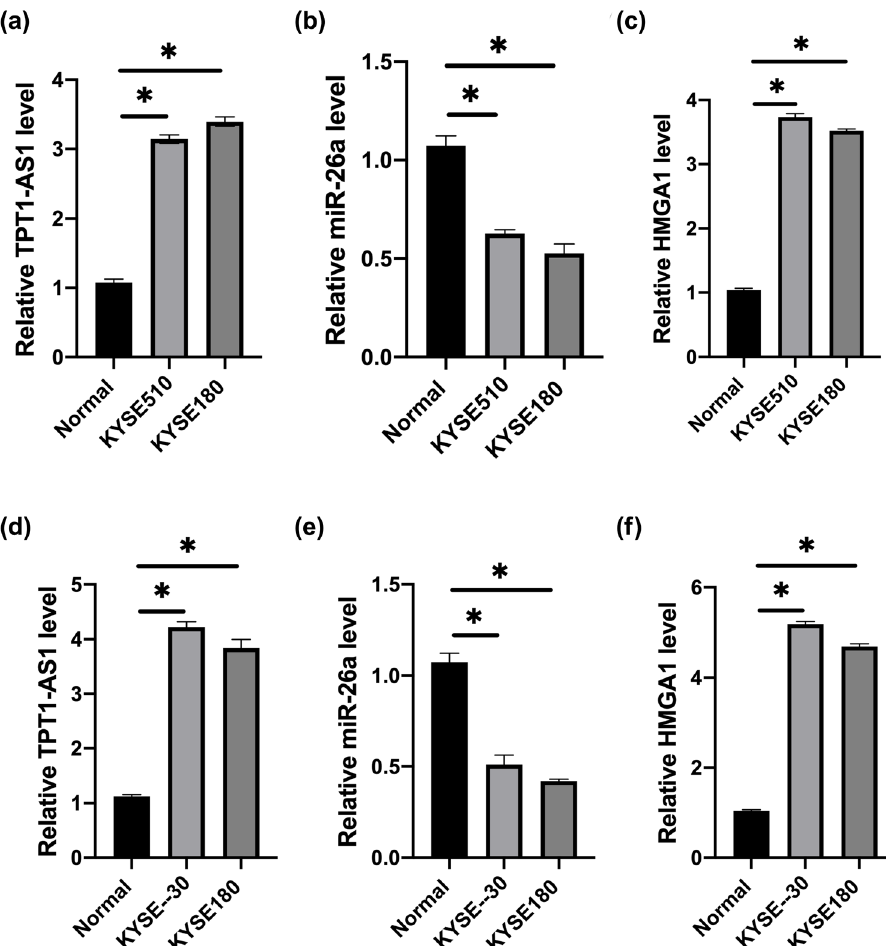
Figure A3: The expression levels of TPT1 - AS1 and miR - 26a/HMGA1 in these two cells were compared with other ESCC cells lines and normal cell line. TPT1 - AS1 ( A, D ) , miR - 26a ( B, E ) and HMGA ( C, F ) levels in ESCC cells and normal cell line were determined by RT -